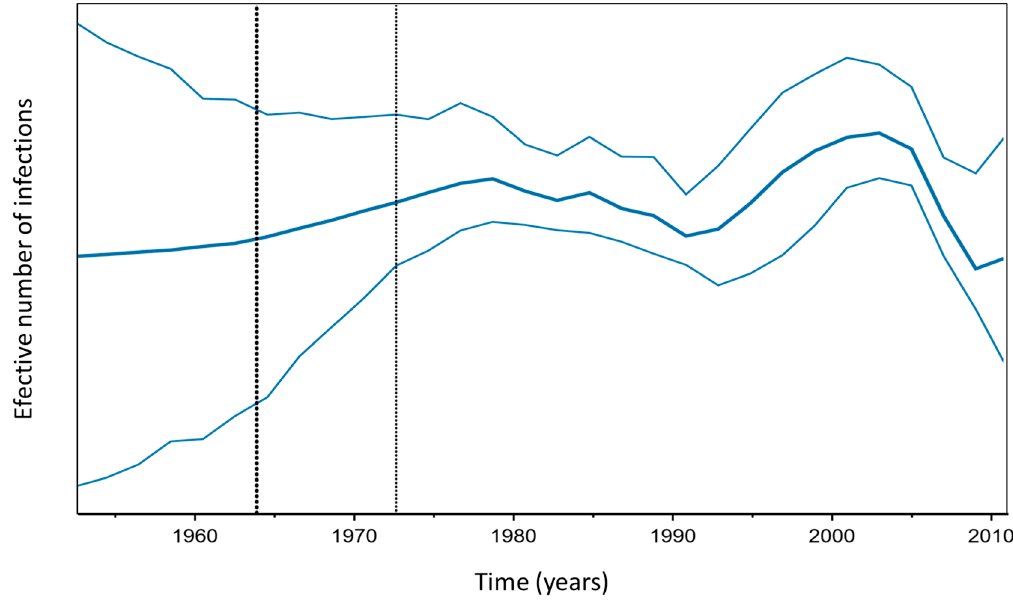
Figure 5. Skygrid reconstruction. In the graph, the relationship between the axes shows the equivalent to the effective number of infections ( y ‐ axis) and the chronological time expressed in years ( x ‐ axis). The thick blue central horizontal line indicates the mean, and the fine lines indicate the 95% HPD interval. The first vertical dashed line indicates the mean root age, or tMRCA (1963), and the second dashed line indicates the highest value of this same variable (1972). These estimates were obtained using multiple alignment with 44 HDV sequences that were isolated at different sites in South America at different points in time.